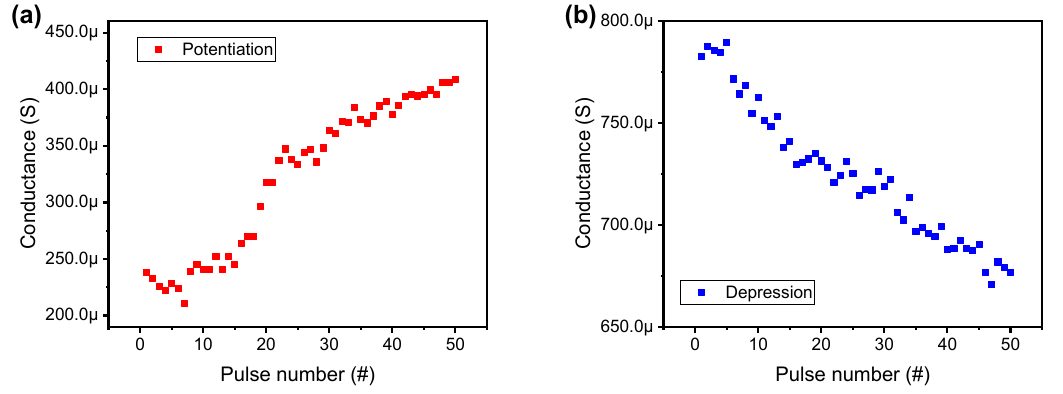
Figure 5. ( a ) Potentiation and ( b ) depression by 50 identical set and reset pulses.